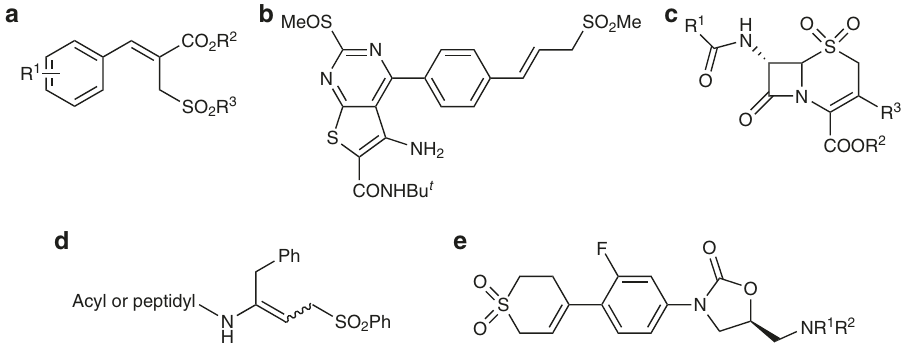
Fig. 1 allylic sulfones moiety in biologically active molecules. a Anticancer agents and anti-abnormal cell proliferation. b TSH receptor antagonists. c Anti- in fl ammatory and antidegenerative agents. d Cysteine protease inhibitors. e Antibacterial